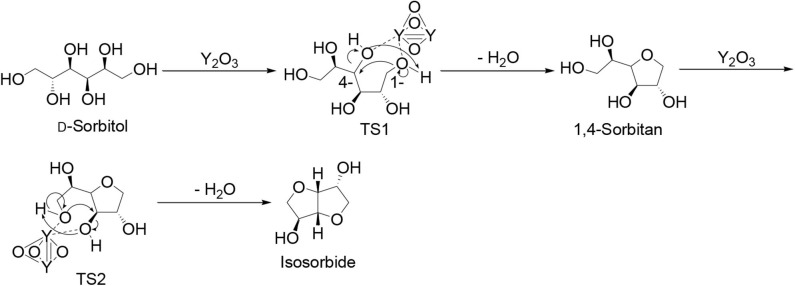
The proposed catalytic mechanism for continuous dehydration of D-sorbitol.